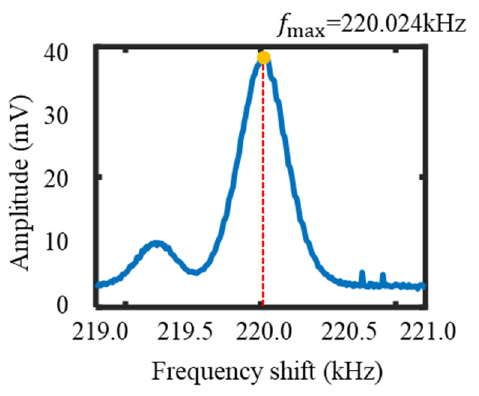
Figure 6. The spectrum of the contact resonant frequency around a local maximum at the start point of the experiment.